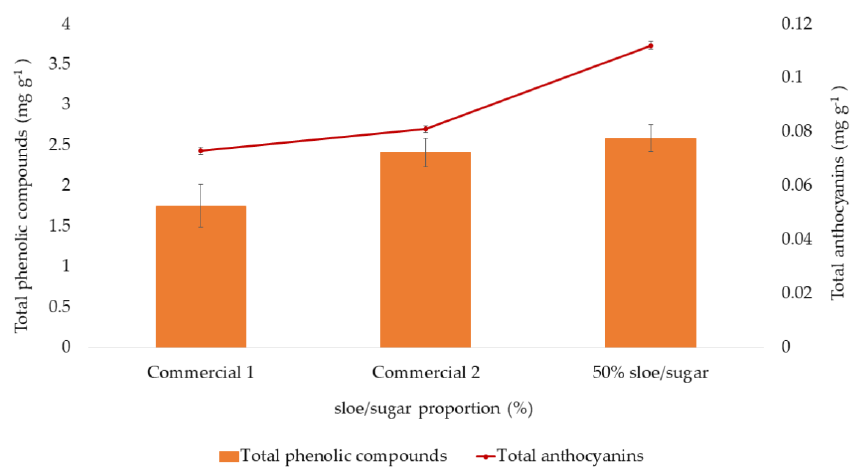
Figure9. Extractionofanthocyaninsandtotalphenoliccompoundsfromdi ff erentsloejamtypes. Results Figure 9. Extraction of anthocyanins and total phenolic compounds from different sloe jam types. are expressed as mg g − 1 of fresh weight (FW) of jam. All results are expressed as means ± standard Results are expressed as mg g −1 of fresh weight (FW) of jam. All results are expressed as means ± deviation (SD) ( n = standard deviation (SD) ( n = 3).